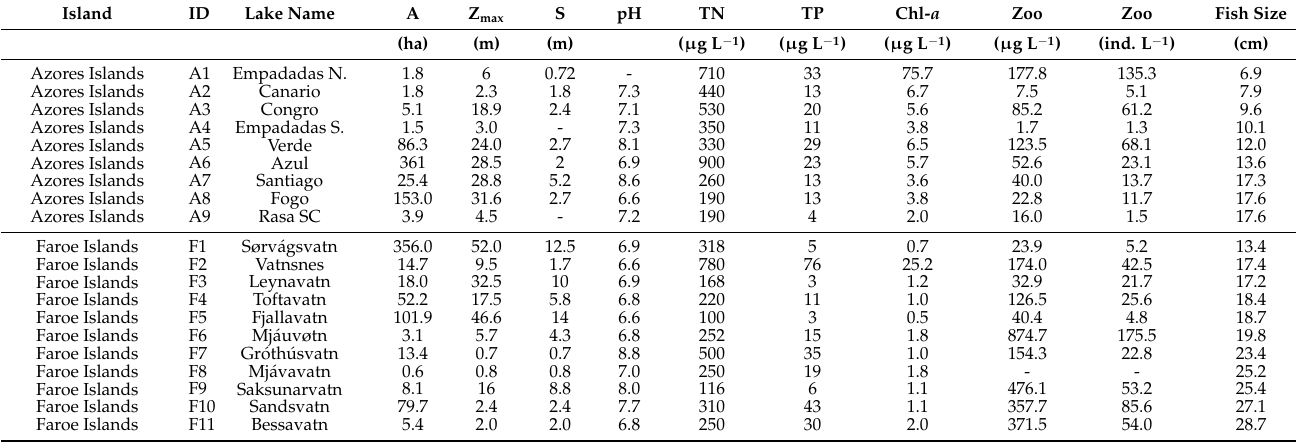
Table 1. Morphometric, basic physical, chemical, and biological characteristics of the study lakes ordered by increasing mean fish size.